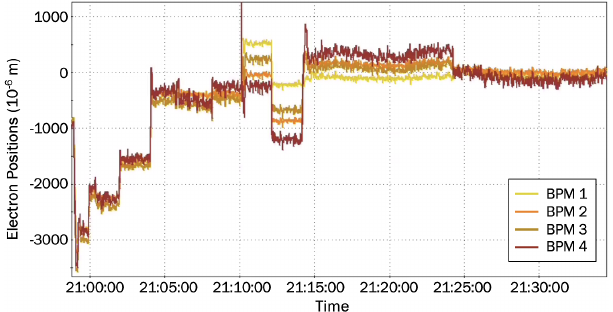
FIG. 12. 20 training points are sampled using Algorithm 2. Both the data-informed (DI) method and the physics model- informed (PMI) method use the same training data.